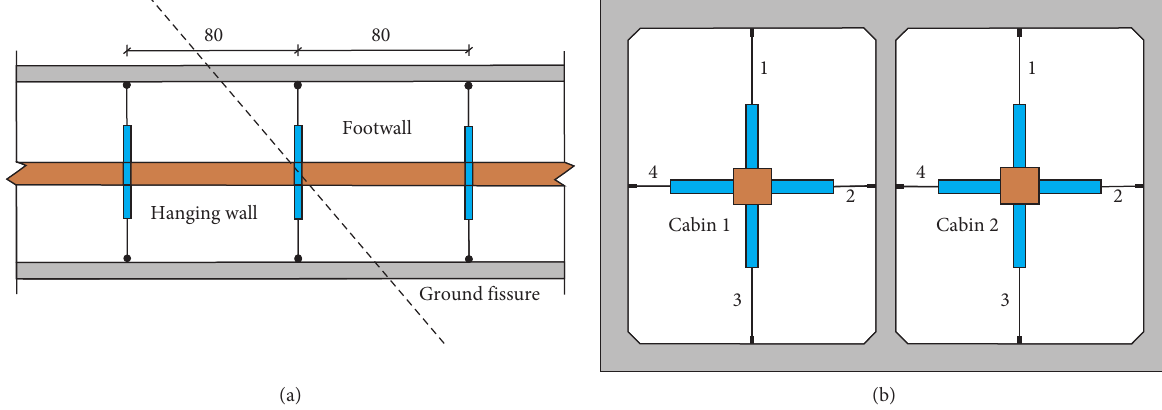
Figure 9: Schematic diagram of displacement meter arrangement (cm). (a) Position of displacement meter (cm). (b) Structure cross- sectional displacement meter layout